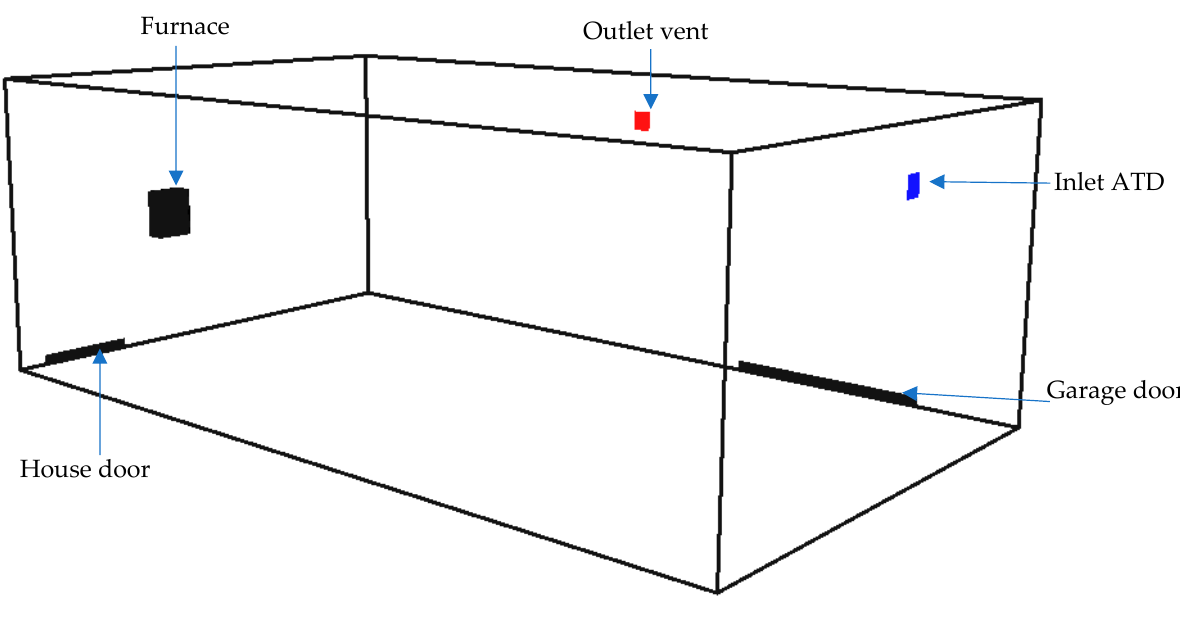
Figure 1. CFD0 wall frame of the garage.